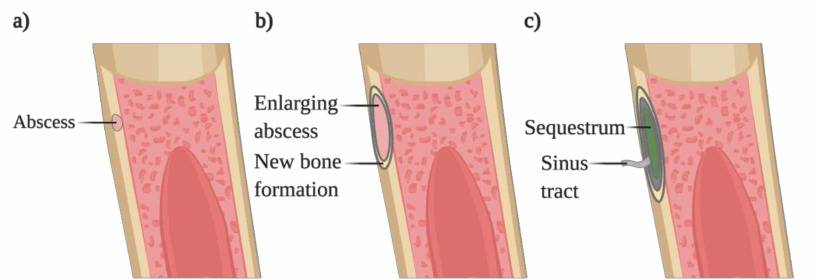
Figure 3. Progression of bacterial osteomyelitis. ( a ) Pathogens colonize the cortical bone, forming an abscess. ( b ) The forming abscess increases in size and is surrounded by new bone formation, causing the elevation of the periosteum. ( c ) The localized infection constricts the vascularization leading to the necrosis of the bone, forming the sequestrum. The sequestrum is surrounded by new bone where a sinus tract will be formed, allowing the drainage of the